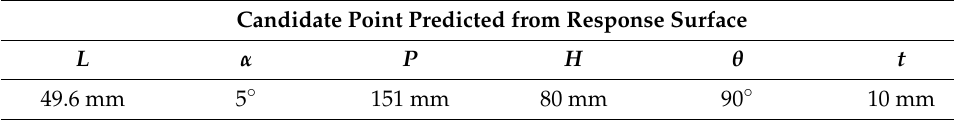
Table 4. The result obtained from response surface.